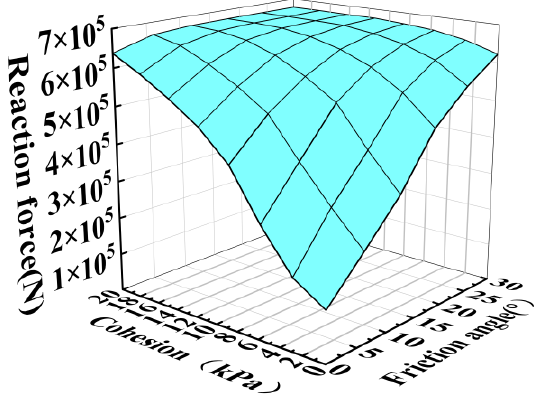
Figure 16. Cohesion – reaction force curve. Figure 16. Cohesion–reaction force curve.